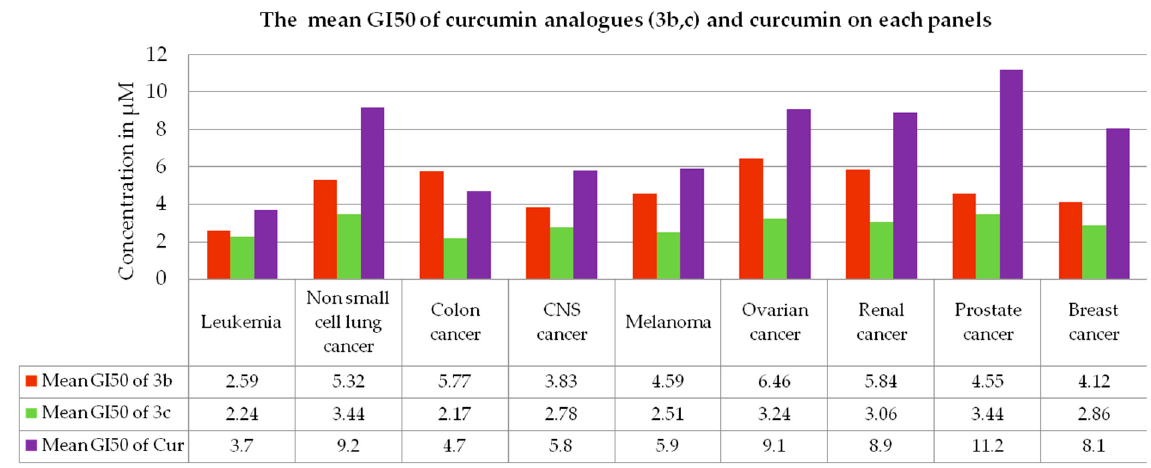
Figure 6. The mean GI 50 of curcumin analogs ( 3b , c ) and curcumin (Cur) on each panel of cancer cell lines in the five-dose assay.